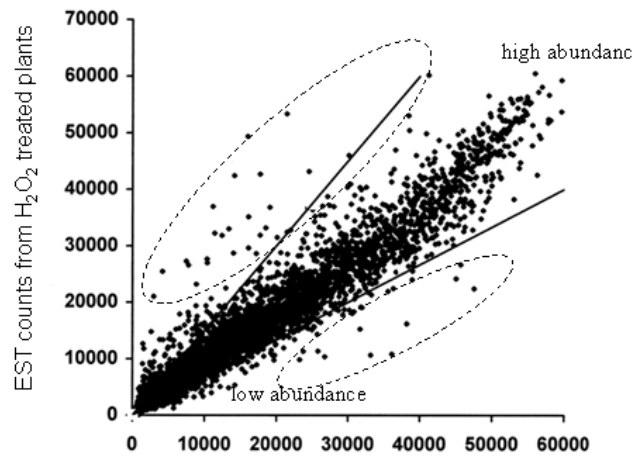
FIGURE 5. Scatter plot of signal intensities for all EST (expressed sequence tags) on the microarray. Normalized channel intensities for each clone on the microarray are plotted with signals from control and H 2 O 2 -treated cells. The diagonal lines represent 1.5-fold induction/repression ratio cutoffs. The ovals represent gene expression that is clearly up-regulated (top oval) or down- regulated (bottom oval). Modified from Desikan et